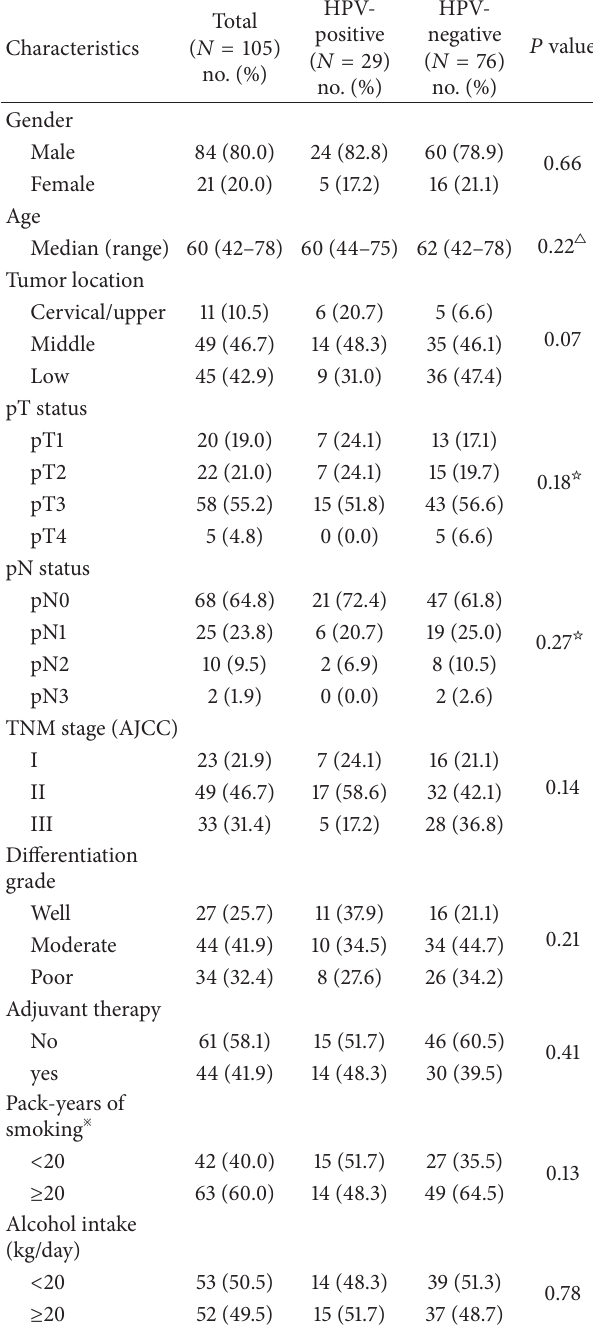
Table 1: Baseline characteristics of the study patients and their tumors, according to tumor HPV